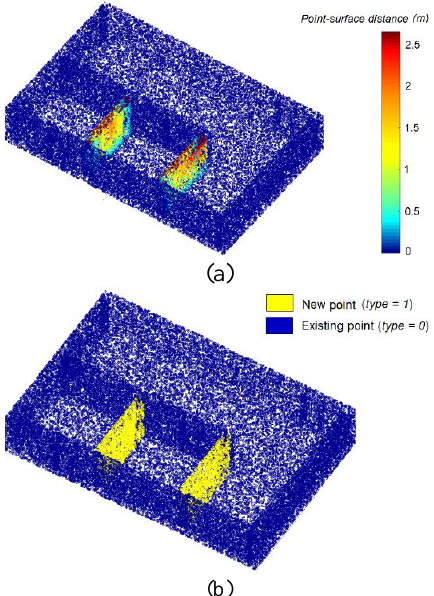
Figure 4. Comparison results of the synthetic dataset: (a) the point cloud colorized according to point-surface distances; (b) the point cloud with the result of point